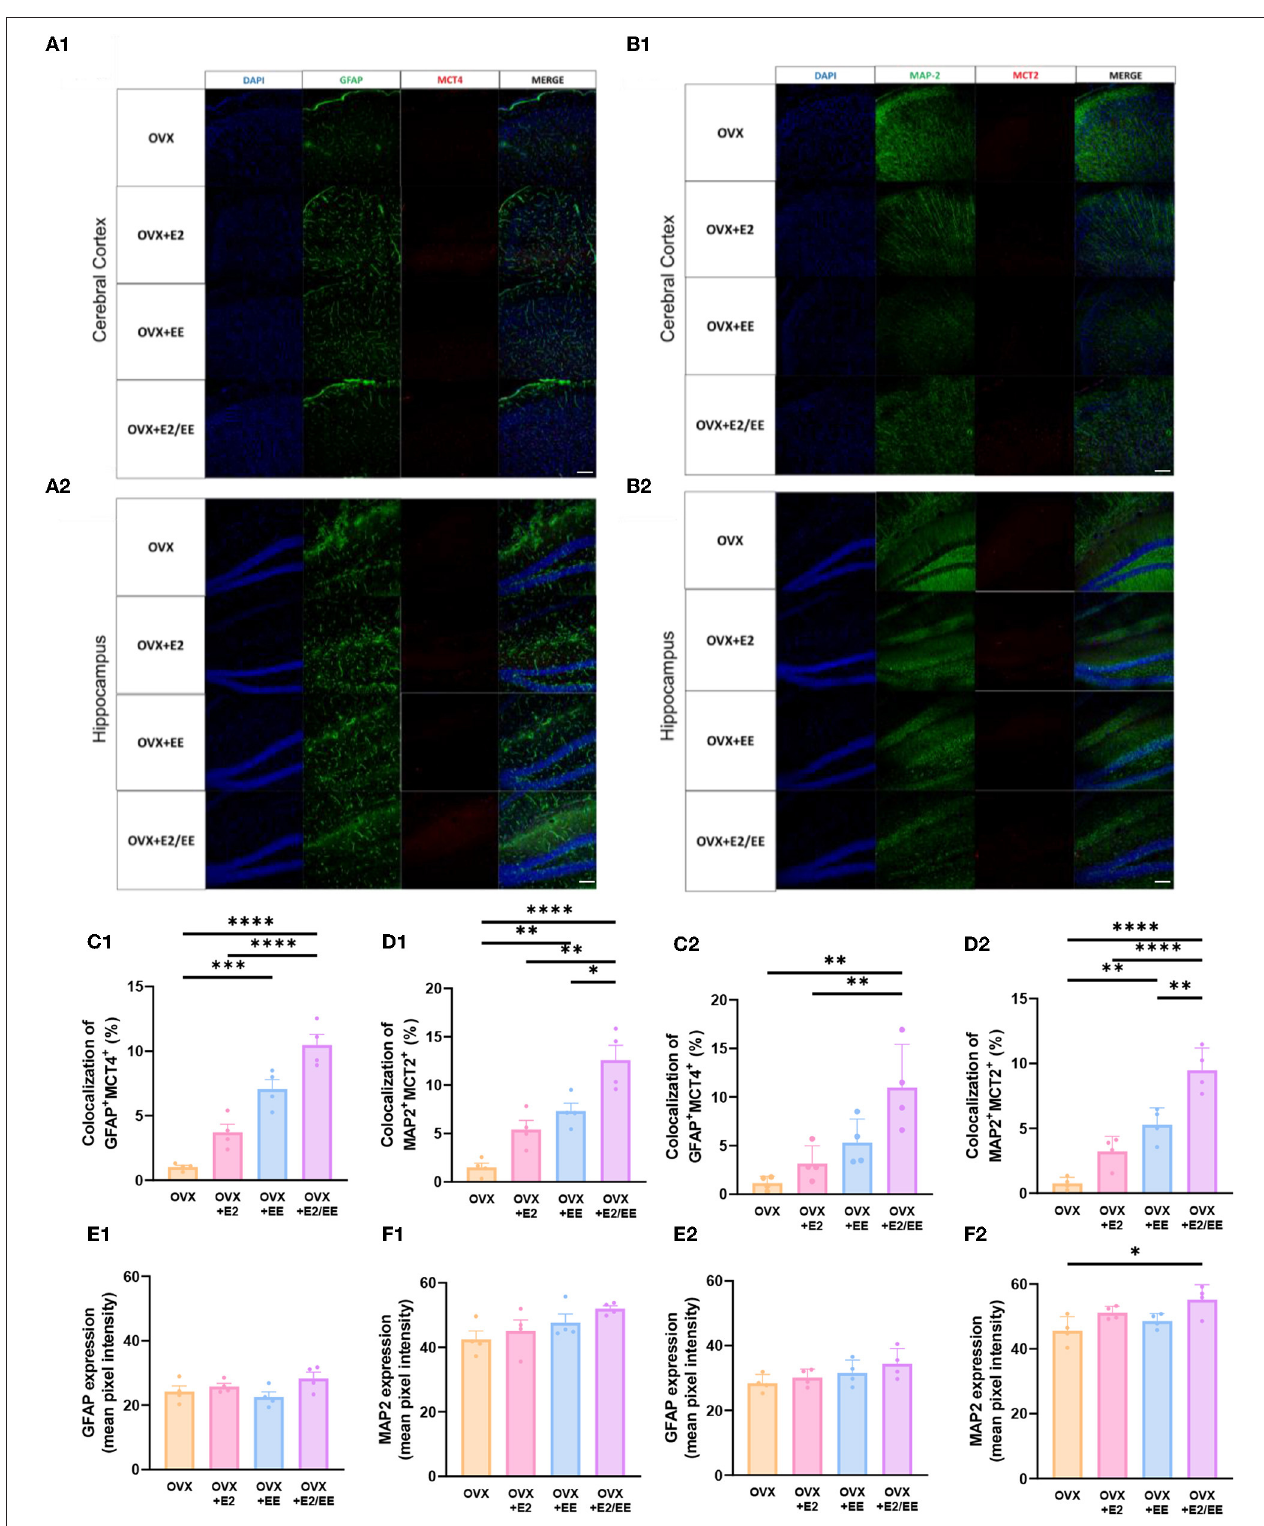
FIGURE 12 | Synergistic effects of estrogen and EE on the uptake of β HB in cerebral cortex and hippocampus. Representative IHC images of (A1,A2) GFAP + MCT4 + in cerebral cortex and hippocampus and (B1,B2) MAP2 + MCT2 + in the cerebral cortex and hippocampus ( n = 4 per group). (C1–F1) Quantification of GFAP + MCT4 + and MAP2 + MCT2 + in the cerebral cortex and hippocampus. (C2–F2) Raw intensity of GFAP and MAP2 in cerebral cortex and hippocampus. One-way ANOVA with Tukey multiple comparison test. Data represented are means ± SEM. * p < 0.05, ** p < 0.01, *** p < 0.001, and **** p < 0.0001. A white bar = 50 µ m.